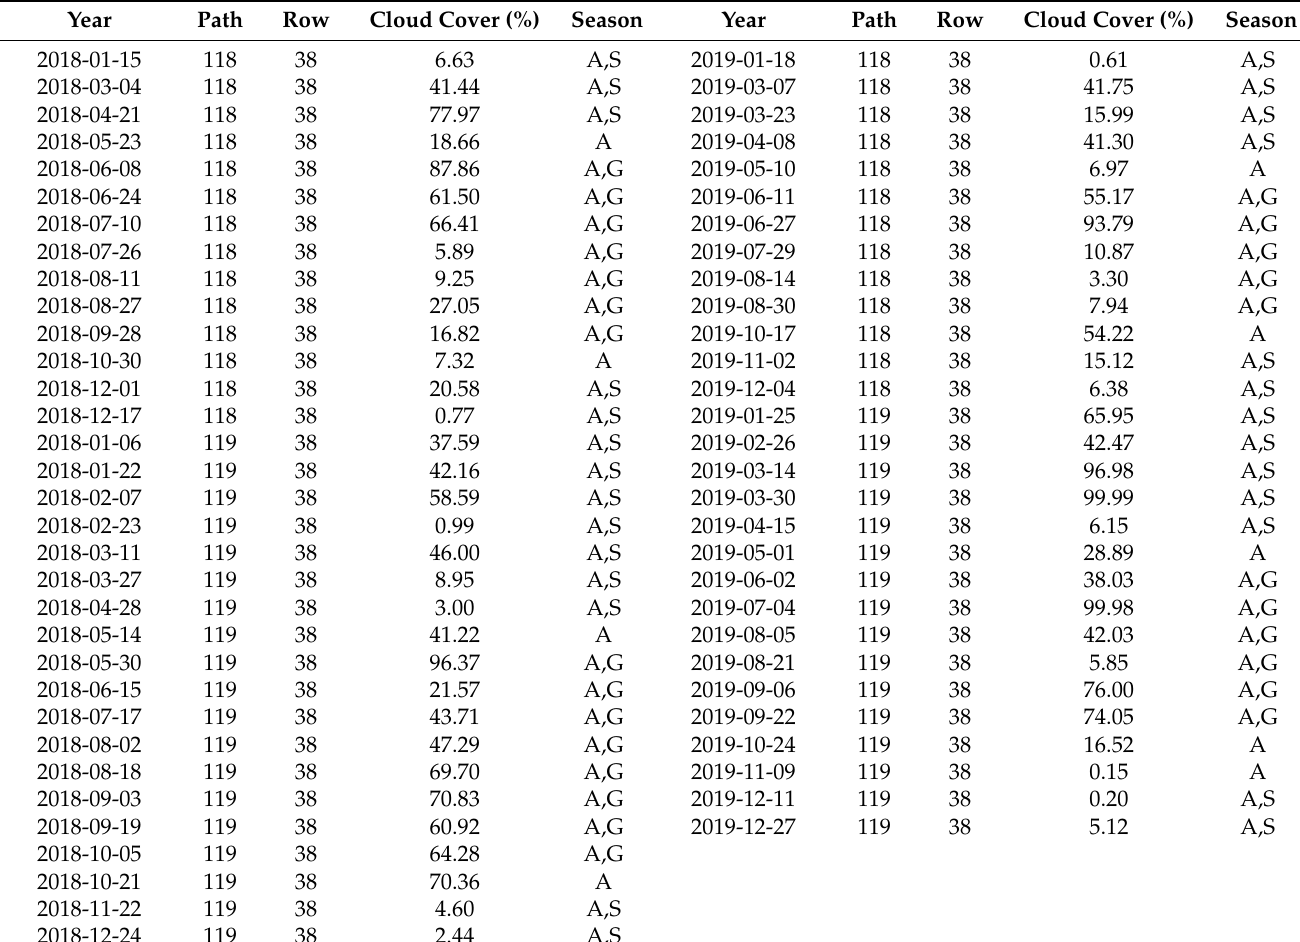
Table 1. Characteristics of the Landsat 8 Operational Land Imager (OLI) images used in the